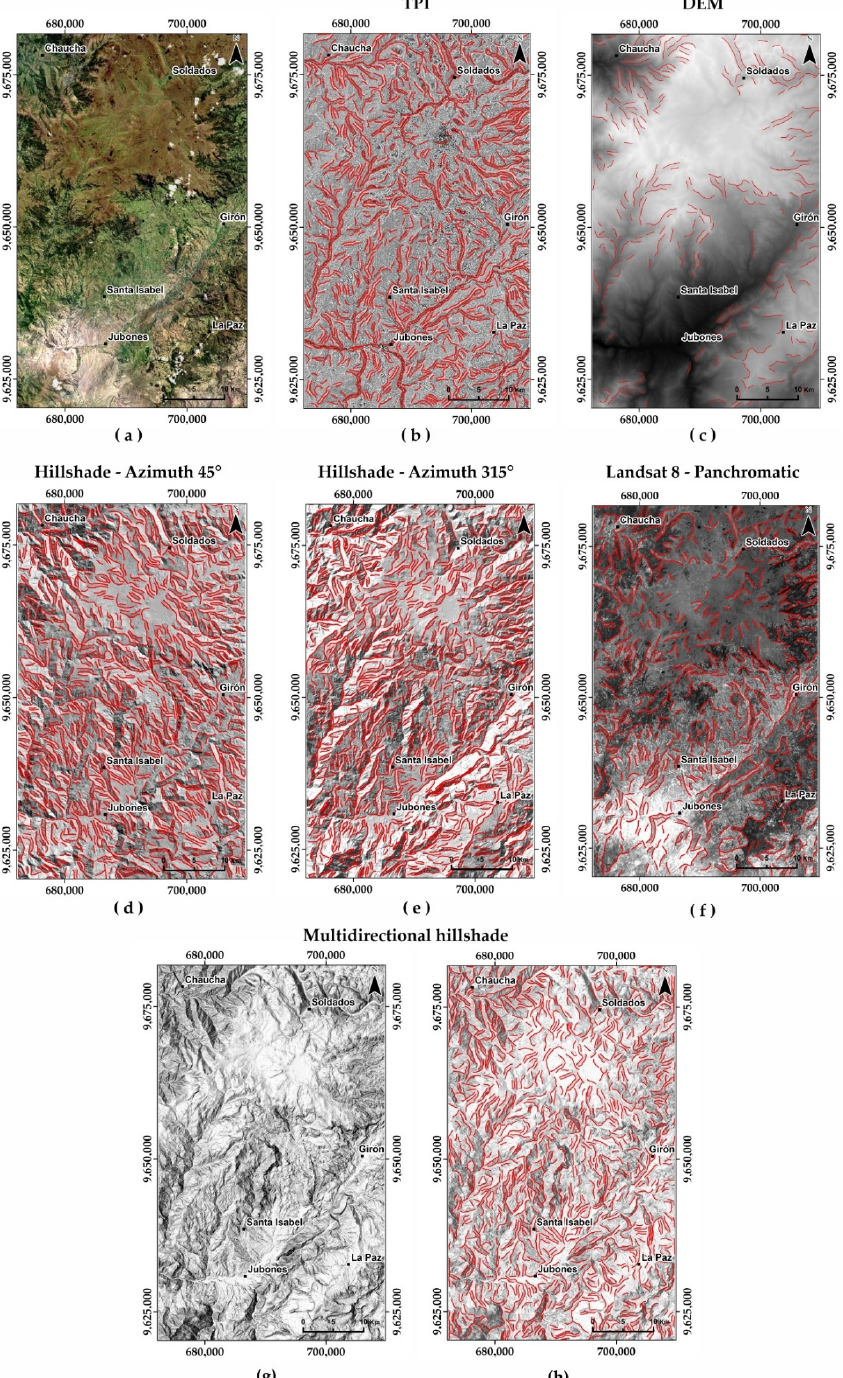
Figure 9 . Comparison of the results of automatic extraction from different base images. Image ( a ) shows the study area, and ( g ) shows the multidirectional hillshade of the area. The others show the automatic lineaments obtained from ( b ) TPI, ( c ) DEM, ( d ) hillshade with an azimuth of 45 ◦ , ( e ) hillshade with an azimuth of 315 ◦ , ( f ) panchromatic from a Landsat 8, and ( h ) multidirectional hillshade. Red lines are the automatic